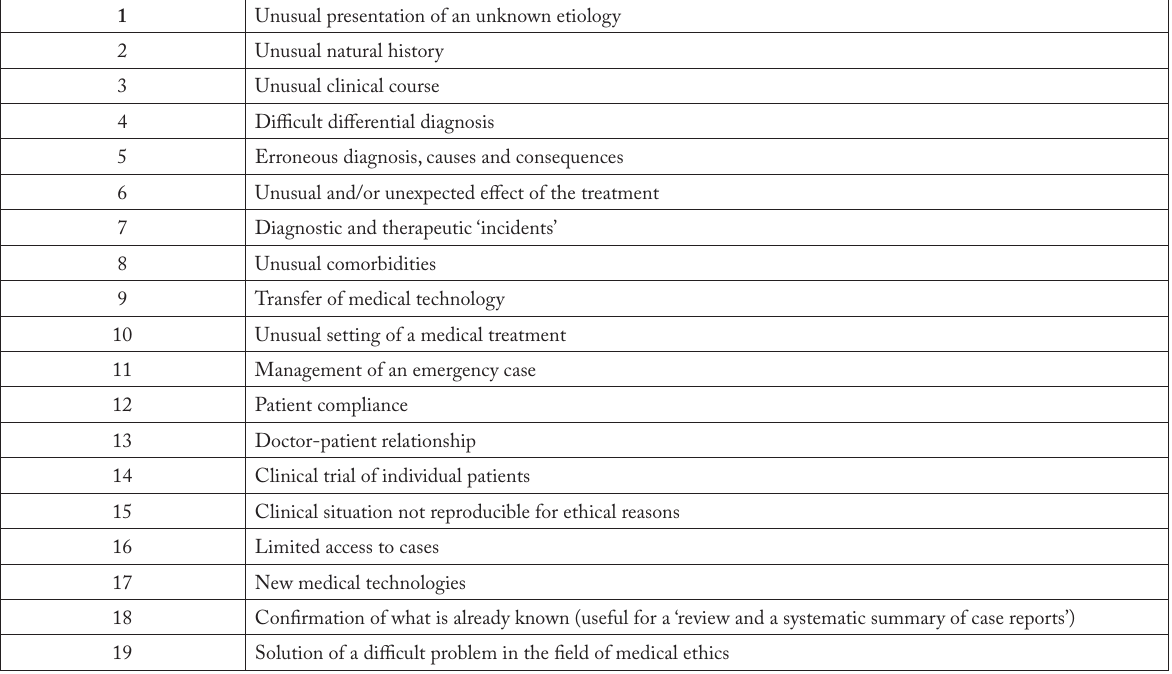
Table 1. Nineteen reasons to publish a case report (modified by Jenicek